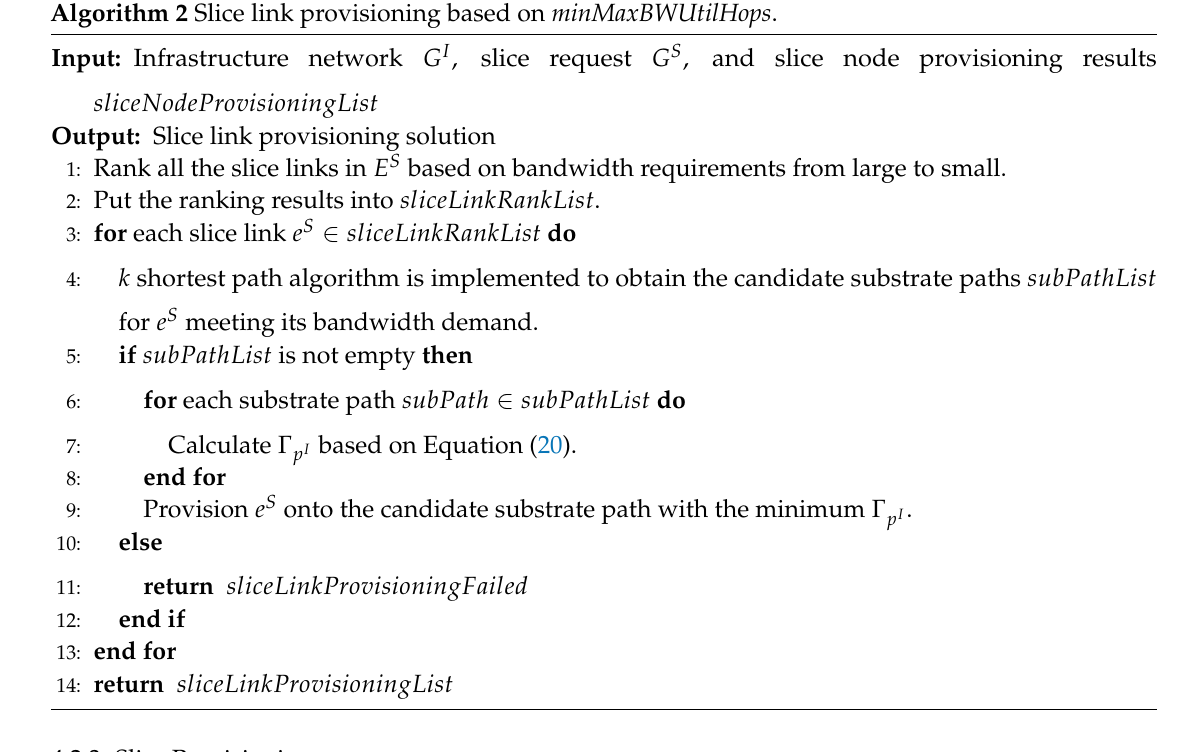
Algorithm 2 Slice link provisioning based on minMaxBWUtilHops